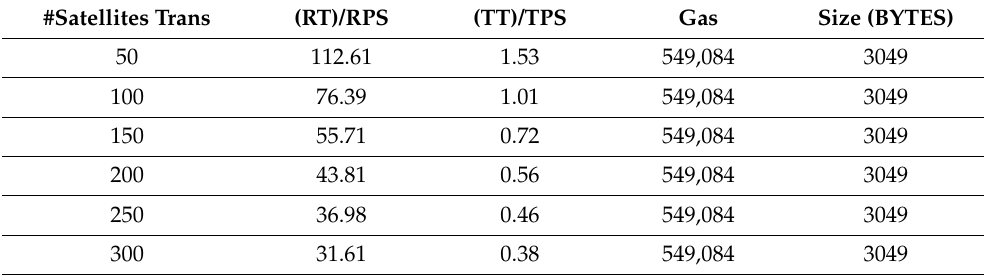
Table 6. Results of the impact of the transactional data size 3049 bytes on RT, and TT according to the number of satellite transactions.